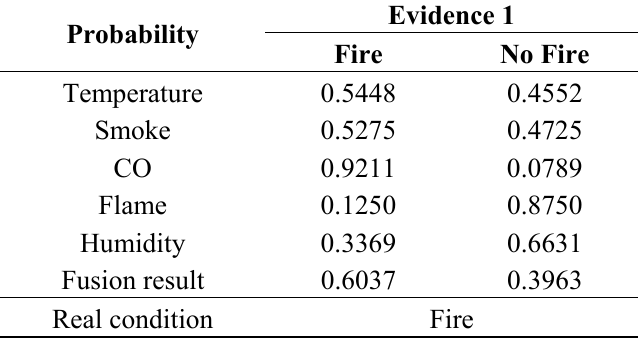
Table 5. Fire probability data and fusion result under Condition